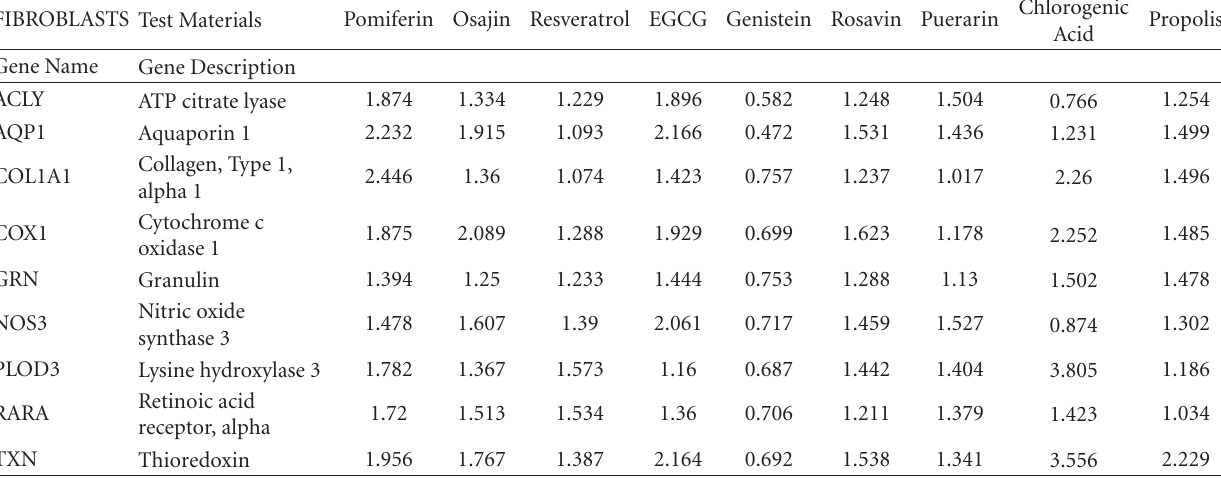
Table 3: Summary of fibroblasts genes noted to be commonly upregulated by the antioxidant treatments. FIBROBLASTS Test Materials